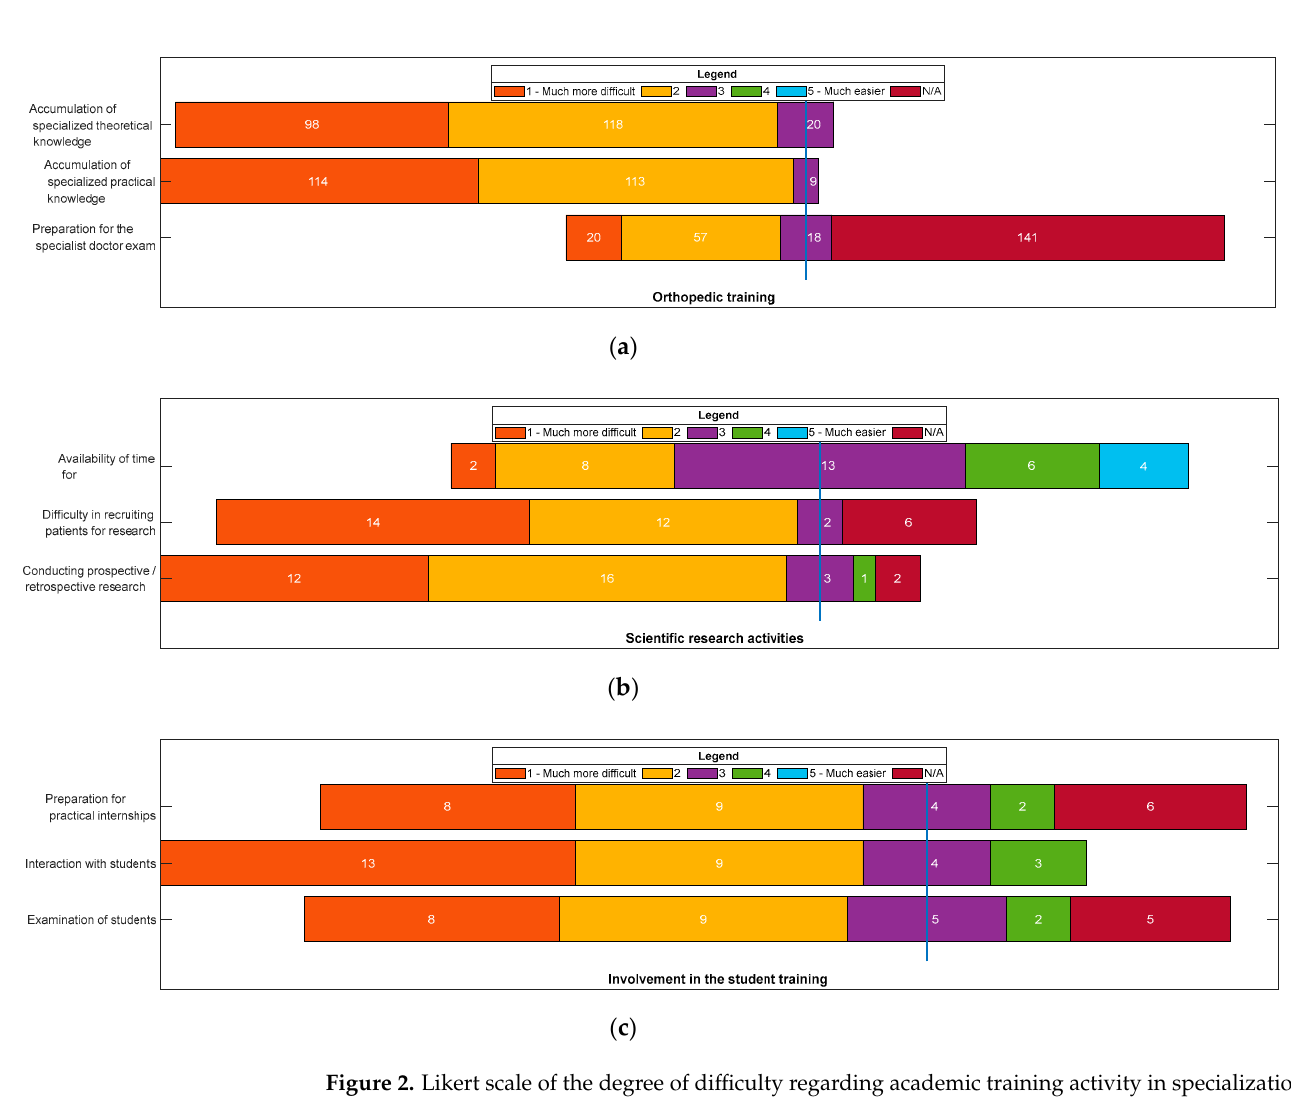
Figure 2. Likert scale of the degree of difficulty regarding academic training activity in specialization: ( a ) Orthopedic training; ( b ) Scientific research activities; ( c ) Involvement in the training of students. Steps on the Likert scale:( 1 ) Much more difficult in pandemic than in ante-pandemic; ( 2 ) More difficult in pandemic compared to ante-pandemic; ( 3 ) In the pandemic, as well as in ante-pandemic; ( 4 ) Easier in pandemic than in ante-pandemic; ( 5 ) Much easier in the pandemic compared to the ante-pandemic period; N/A not applicable.